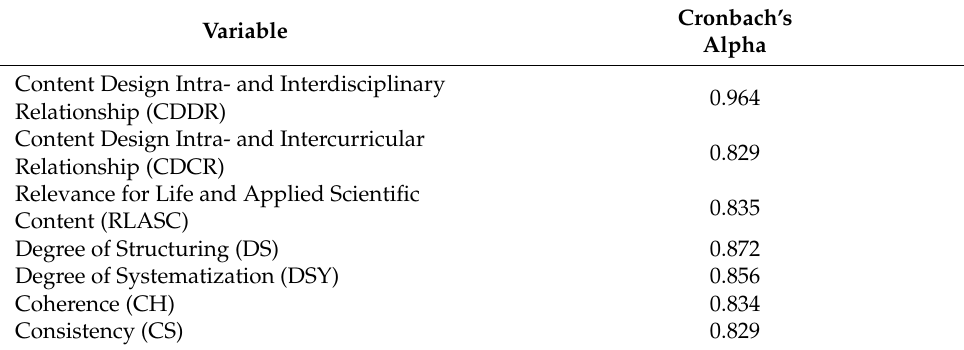
Table 1. Summary of processed cases of variables. Reliability